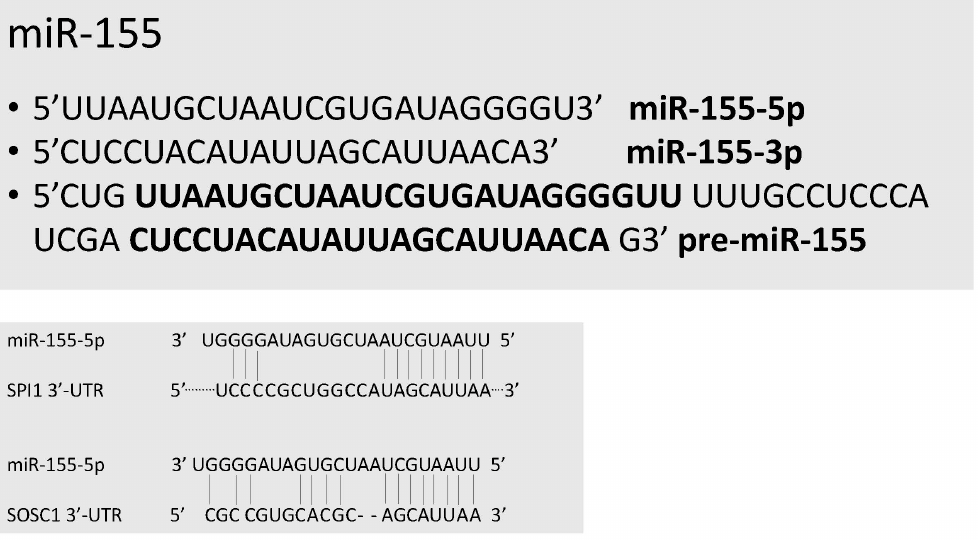
Figure 4. miR-155. Top panel: Sequence of pre-miR-155, mature miR-155-5p and miR-155-3p. Bold letters correspond to the sequence of mature miRs. Bottom panel: Molecular targets of miR-155: SPI1 and SOCS1.